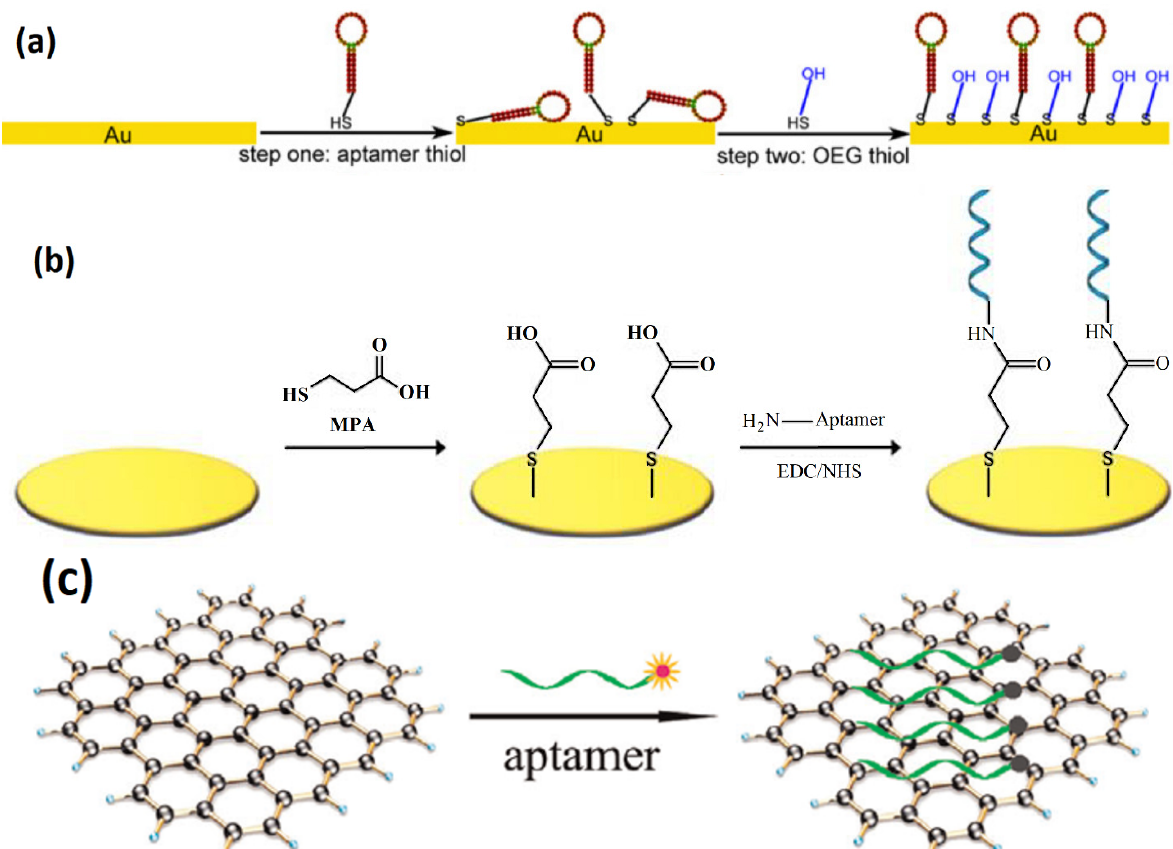
Figure 4. Aptamer immobilization via Au-S bonds ( a ), adapted from [68]; covalent attachment ( b ), adapted from [33]; and direct π - π stacking ( c ), adapted from [70], respectively. Incubation with OEG thiol in ( a ) blocks available functional groups after aptamer immobilization, thereby reducing non-specific protein adsorption.